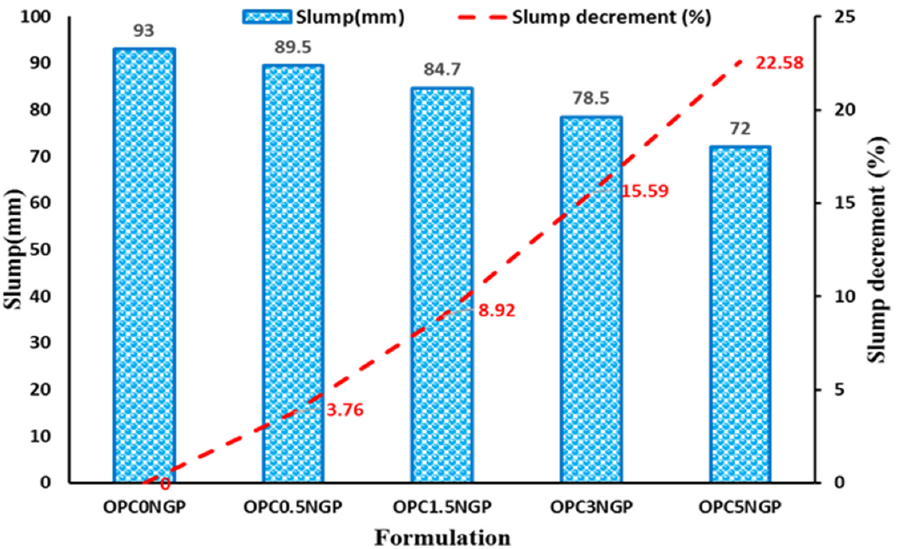
Figure 4. Effect of NGPs on the workability of concrete.